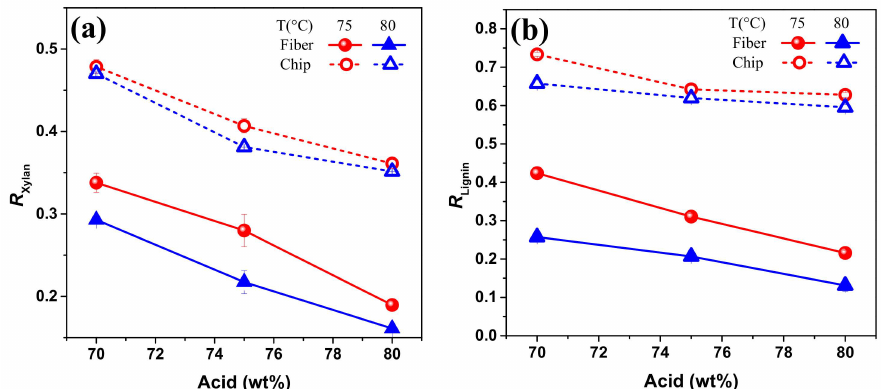
Figure 5. Remaining rate of ( a ) xylan and ( b ) lignin (R Xylan and R Lignin ) under di ff erent concentration of p -TsOH hydrolysis. Acid concentration is 70, 75 and 80 wt %; hydrolysis temperature is between 75 and 80 ◦ C; hydrolysis duration is 20 min. Fiber and chip represent poplar with and without disk refining treatment, respectively.